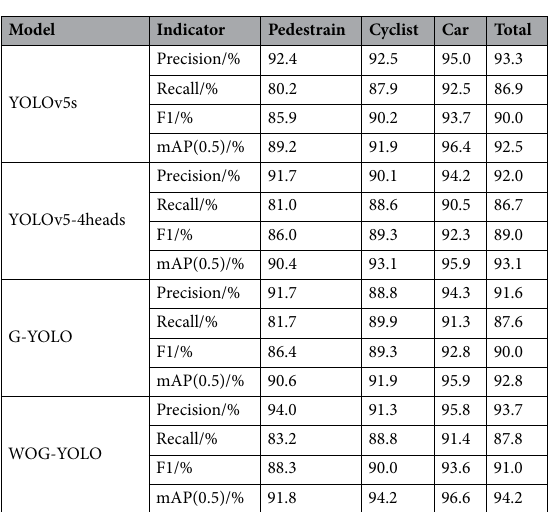
Table 5. Results of WOG-YOLO with different improvements.